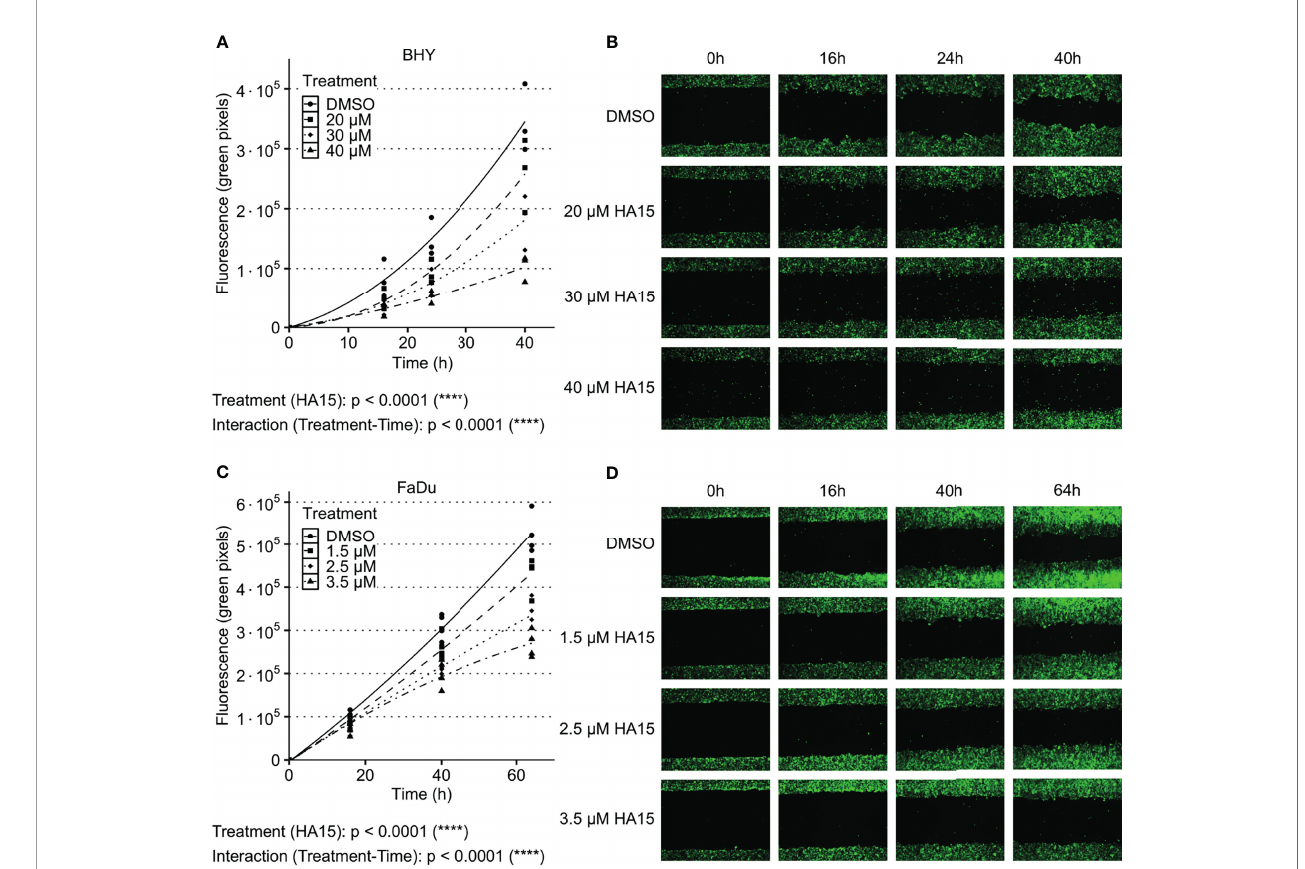
FIGURE 5 | Inhibition of GRP78 impairs migration in HNSCC cells. (A – D) Cell migration analysis (gap fi lling) of GFP-expressing BHY (A, B) and FaDu (C, D) cells after treatment with GRP78-inhibitor HA15 in different concentrations show a dose dependent decrease of cell migration. DMSO was used as control (n ≤ 4, Two- way RM